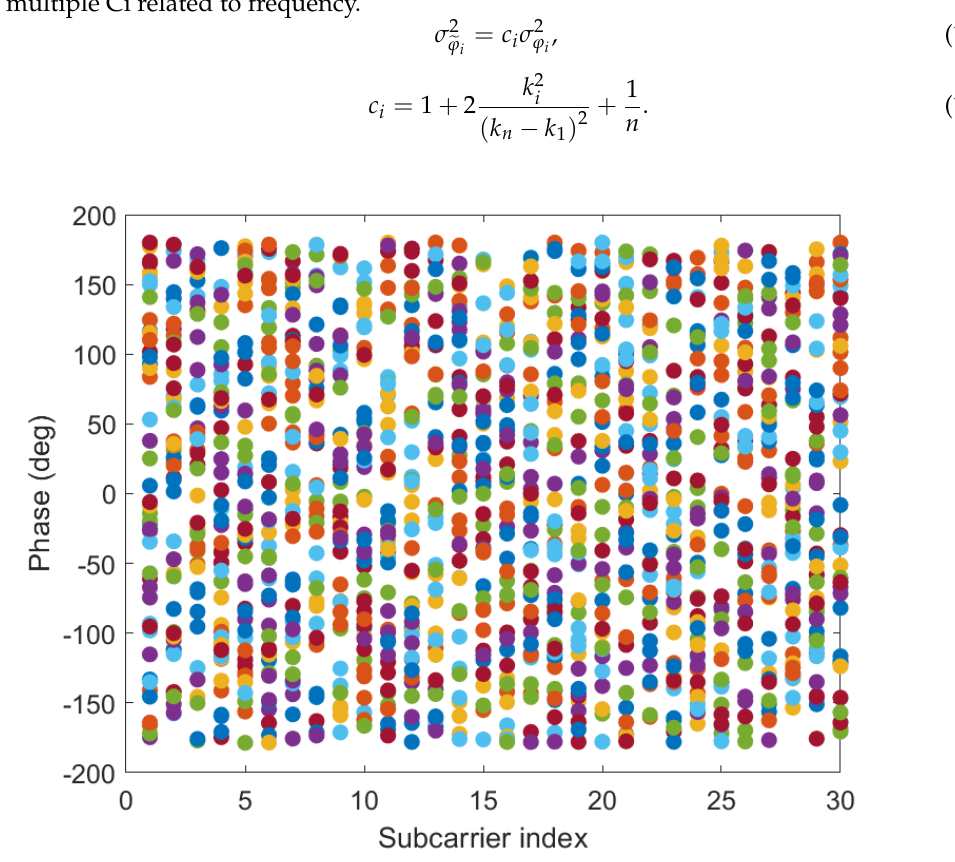
Figure 12. The phases of the 30 CSI sub-carriers on antenna a at reference point (0,1) of AP1 in the corridor of IT1